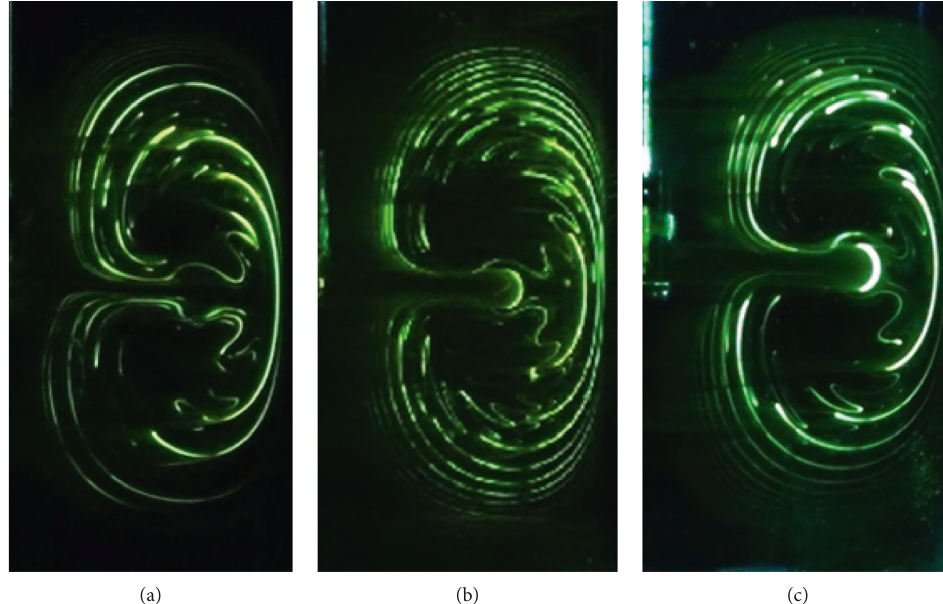
Figure 4: Streak line patterns of a paddle impeller at Re � 70. (a) n � 25rpm; (b) n � 50rpm; (c) diameter � 1.3 D